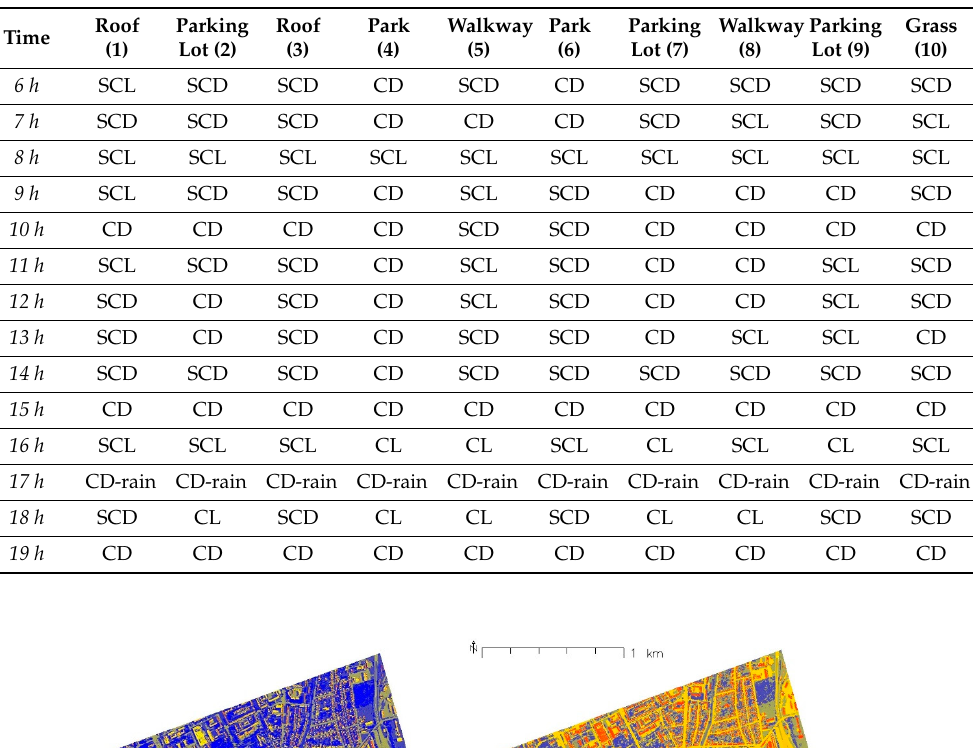
Table 2. The cloudiness conditions (clear = CL, semi-clear = SCL, semi-cloudy = SCD, cloudy = CD) in 10 locations in the study area on 25 June 2020.